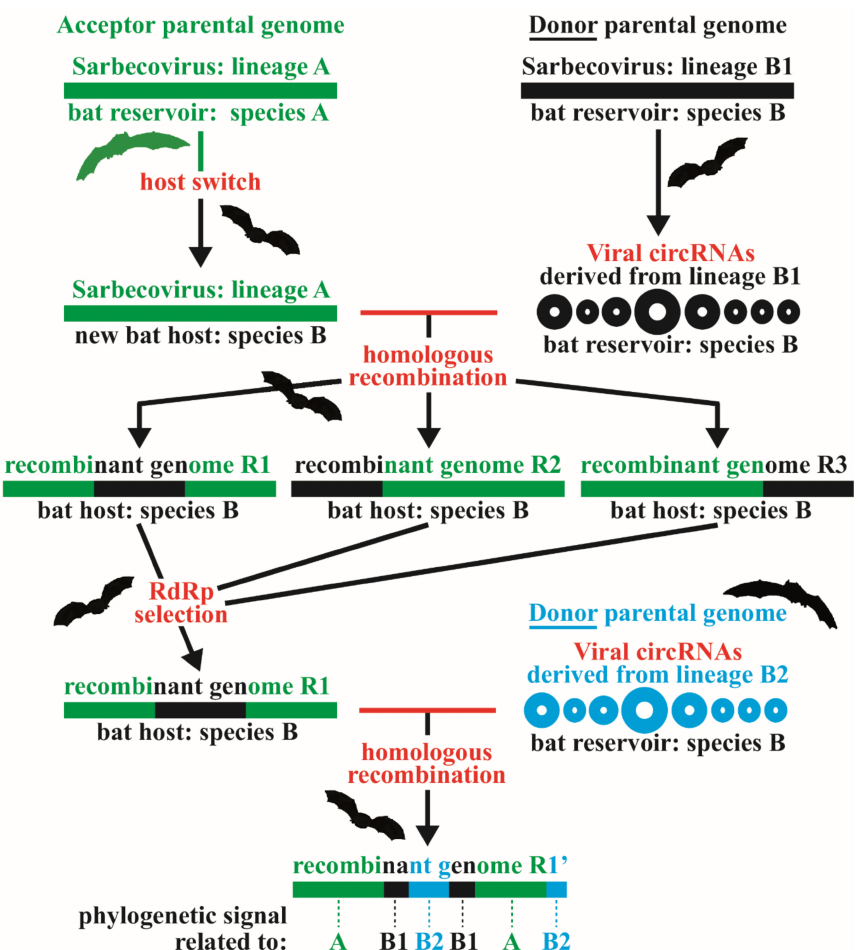
Figure 8. Model of recombination between different Sarbecovirus lineages. The two parental genomes are defined as acceptor and donor. We assumed that the donor parental genome was preserved in the host cell as circular RNA molecules (see Section 4.4), whereas the cell was subsequently infected with the acceptor parental genome. Then, the process of homologous recombination can generate different patterns of recombinant genomes, which are selected based on their capacity to replicate efficiently in the bat reservoir host, i.e., through the sequence of their RNA-dependent RNA polymerase (RdRp). According to this model, the accumulation of recombination events over time has led to mosaic genomes in which different regions can carry incongruent phylogenetic